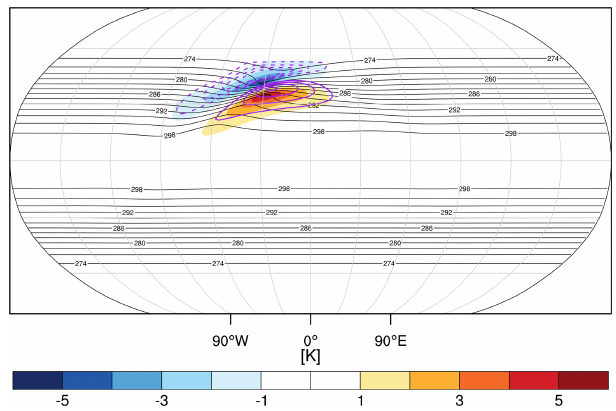
Figure A1. Zonally symmetric initial SST profile known as “Qobs” (black contours), additional SST anomaly used to construct the SST front (colored shading), and resulting 2m temperature anomaly cal- culated as a deviation from the climatological zonal mean 2m tem- perature (purple contours with solid lines indicating positive values and dashed lines negative values; ± 1, 1.5, 2, and 2.5 ◦ ). The latter is shown in all figures in the